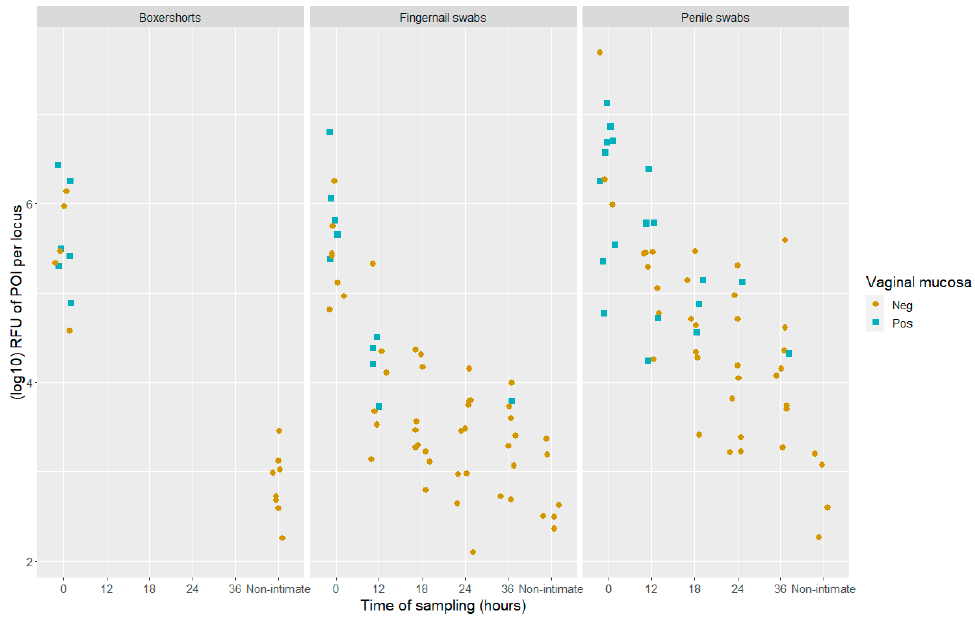
Figure 4. Scatter plots of DNA quantity ( log (cid:2869)(cid:2868) 𝑅𝐹𝑈(cid:3364)(cid:3364)(cid:3364)(cid:3364)(cid:3364)(cid:3364) (cid:3017)(cid:3016)(cid:3010) ) in positive samples (LR > 10 000) which gave a positive (blue) or negative (light brown) test result for vaginal mucosa with the BFID-cSNP-6F assay and MPS technology. The samples are divided into locations and time of sampling, both post- intimate contact and non-intimate contact, n =